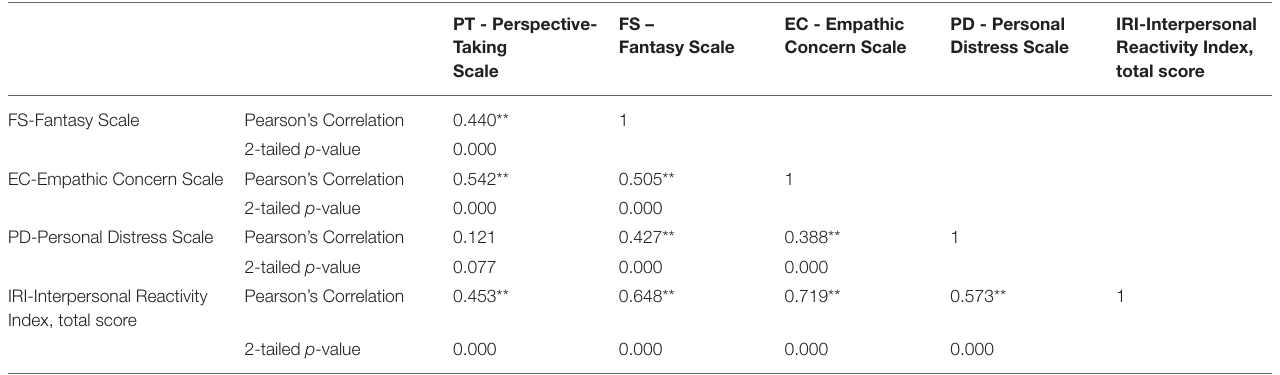
TABLE 1 | Correlations between subscales of self-assessed empathy by Interpersonal Reactivity Index (IRI)